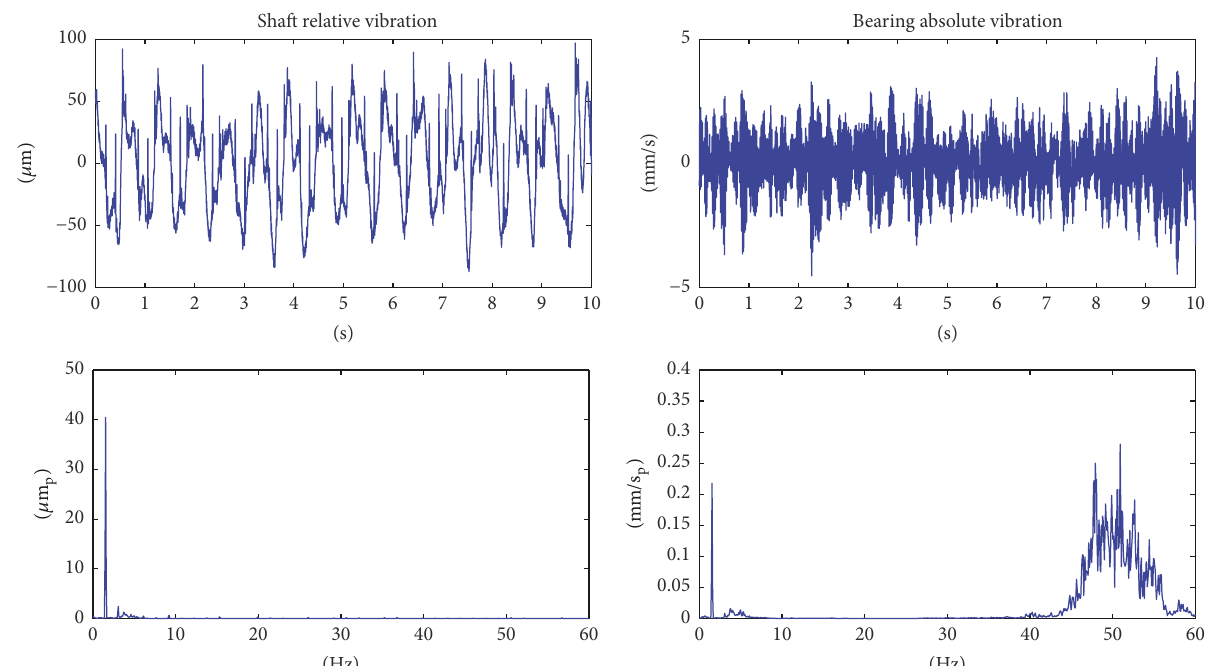
Figure 15: Measured shaft relative and bearing absolute vibrations at 𝑋 direction of the upper journal bearing, when generator rotor had an unbalance G4.25.